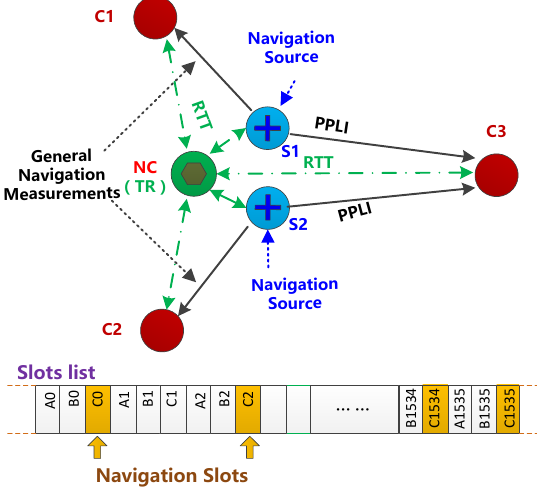
Figure 1. JTIDS navigation network architecture.